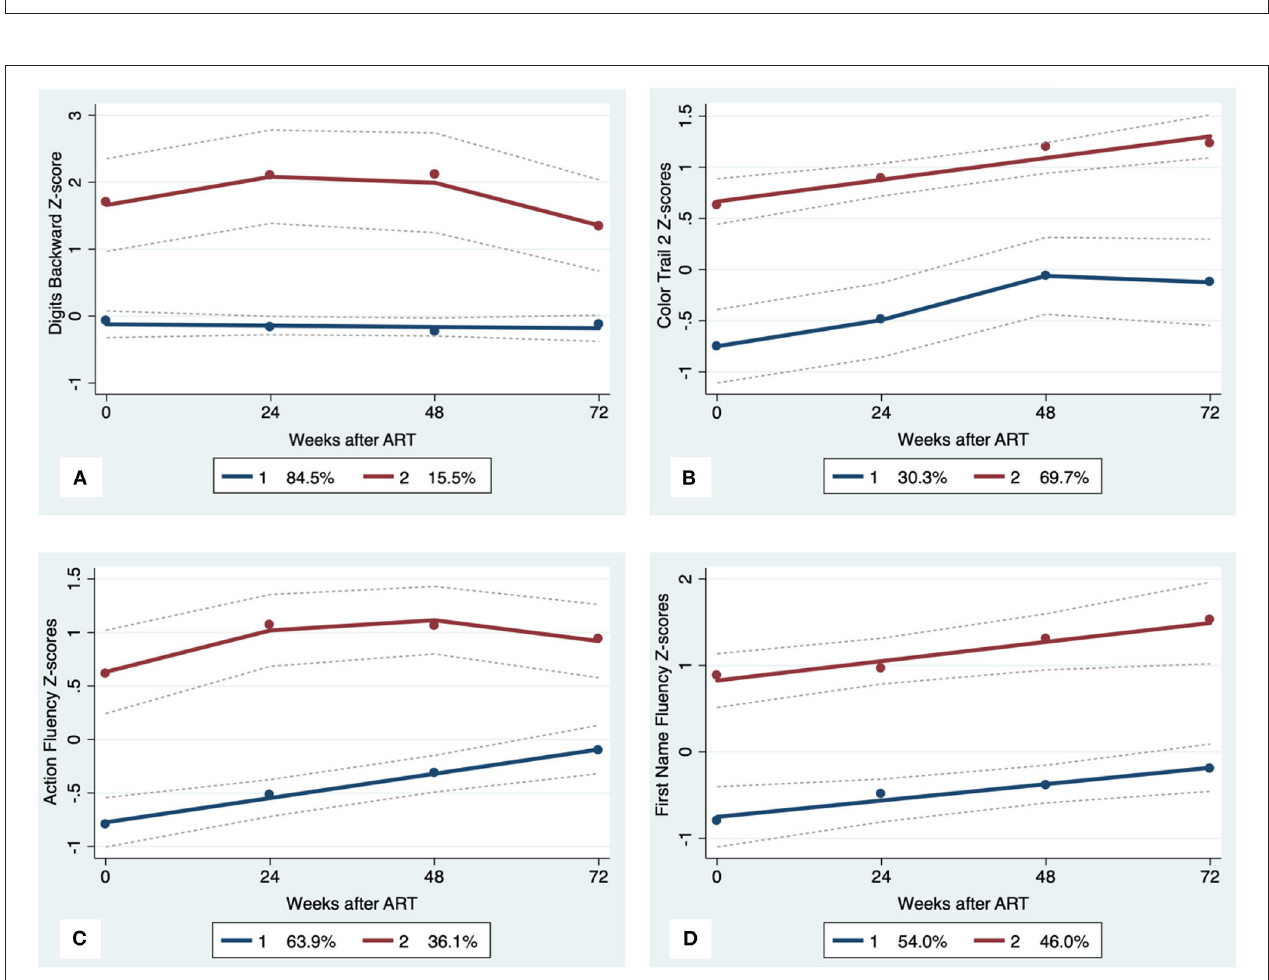
FIGURE 1 | Psychomotor trajectory groups. Solid lines represent estimated trajectories, dot symbols are observed group means at each assessment wave, and dashed lines are 95% pointwise confidence intervals on the estimated trajectories. (A) WAIS-III Digit Symbol and (B) Color Trails 1.